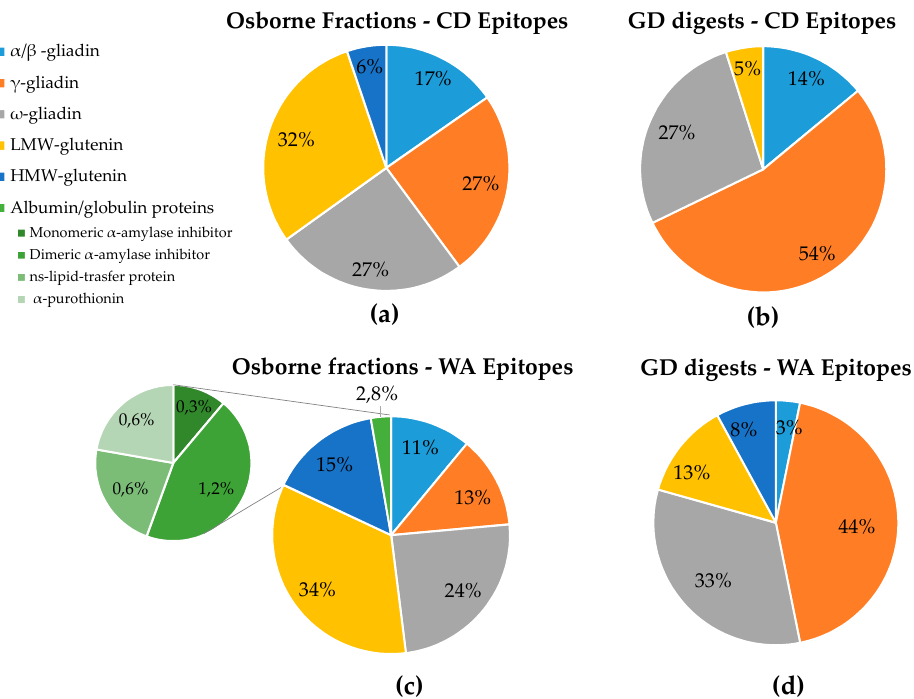
Figure 4. Distribution among main proteins of the detected CD ( a – b ) and WA ( c – d ) epitopes in Osborne fractions and GD digests.